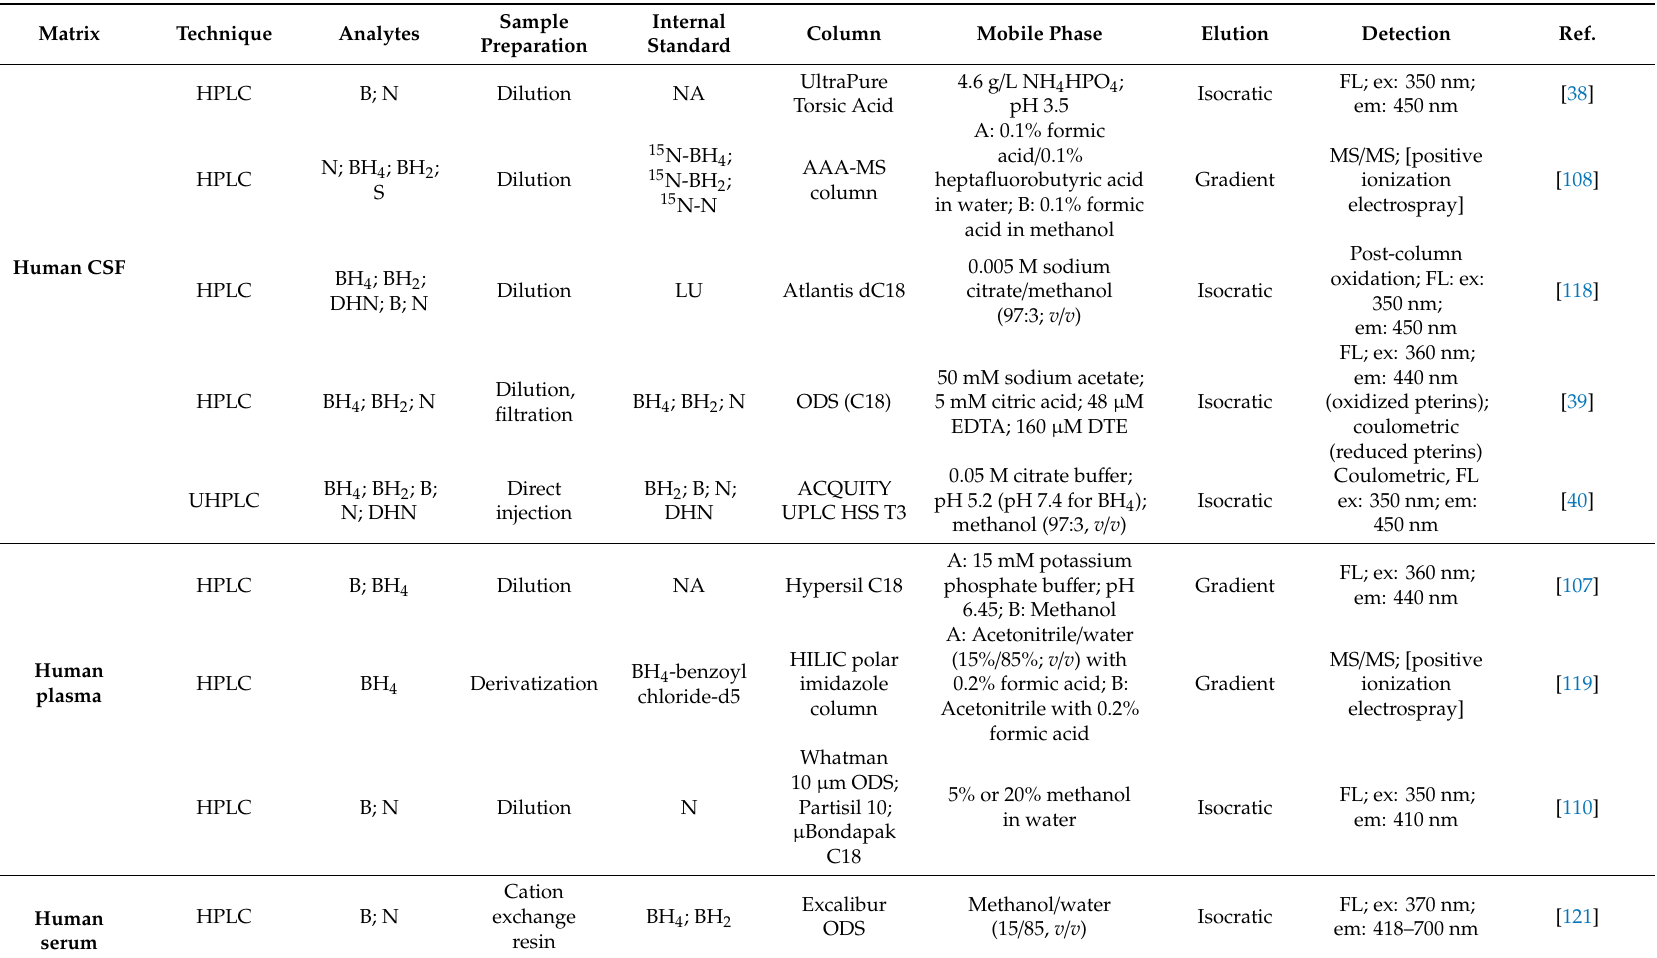
Table 5. Liquid chromatography techniques for the quantitative measurement of pterins in di ff erent human